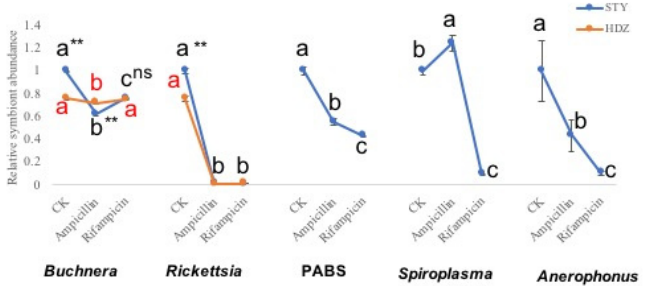
Figure 1. Relative abundance of endosymbiont in the Shanxi Taiyuan (STY) geographic population and Hennan Dengzhou (HDZ) geographic population of Sitobion miscanthi with and without antibiotic treatment. Comparison between the two aphids’ geographic population in one endosymbiont; ** significantly different (Student’s t − test, p < 0.01). Comparison among the expression profiles of endosymbiont treated with different antibiotic in the same aphid geographic population; “abc” significantly different ( p < 0.01); “ns” no significantly different ( p < 0.01).